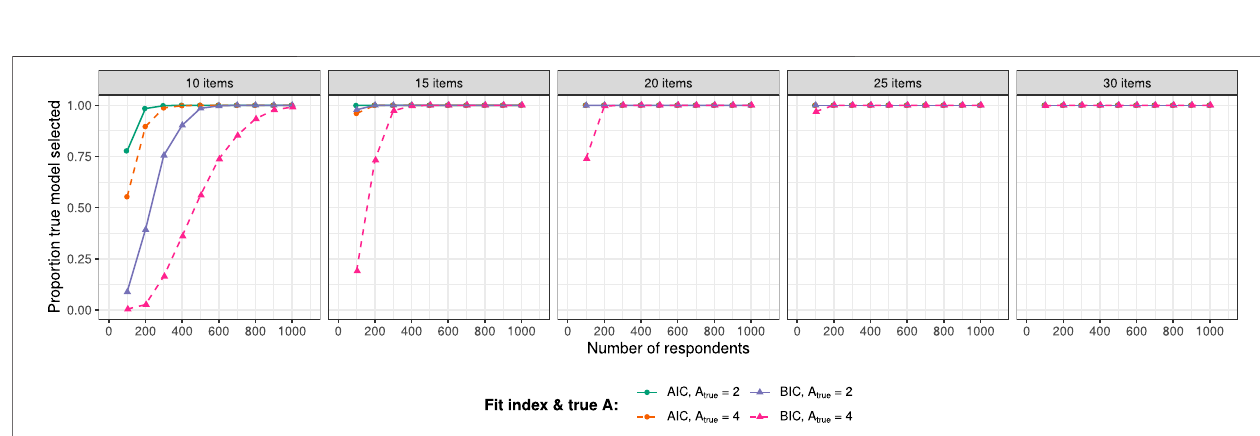
Frontiers in Education |